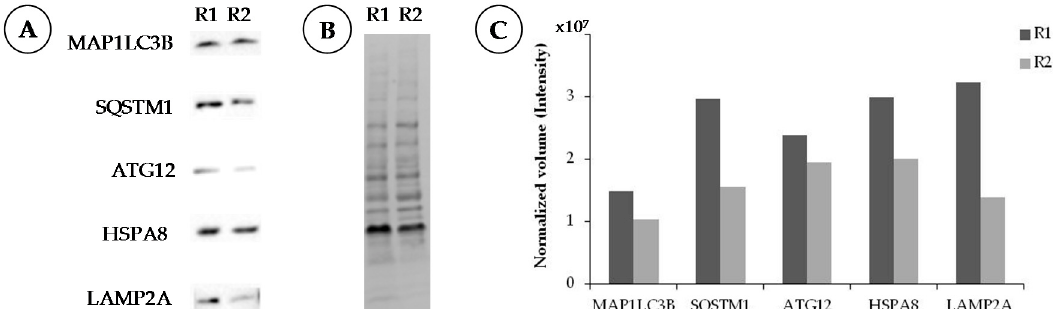
Figure 4. Western immunoblot analysis of sciatic nerve extracts from two adult Lewis rats R1 and R2. ( A ) Expression of autophagy markers MAP1LC3B, SQSTM1, ATG12, HSPA8, and LAMP2A; ( B ) Total protein used as normalization control visualized by stain-free technique; ( C ) Quantification of protein expressed as normalized volume (intensity).